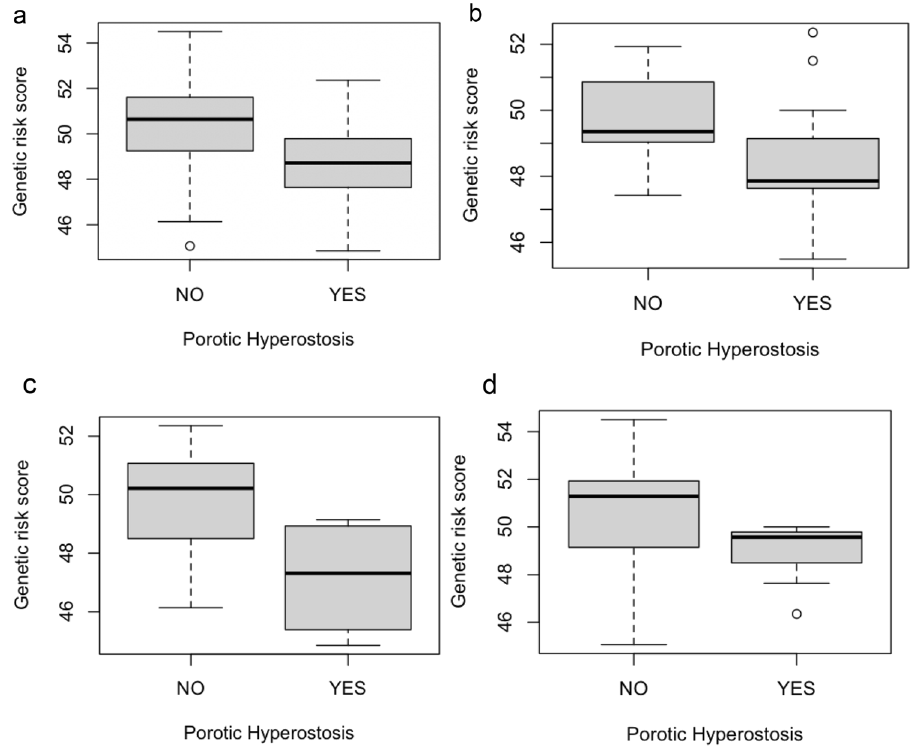
value = 0.05366. ( d ) Copper Age, p value =